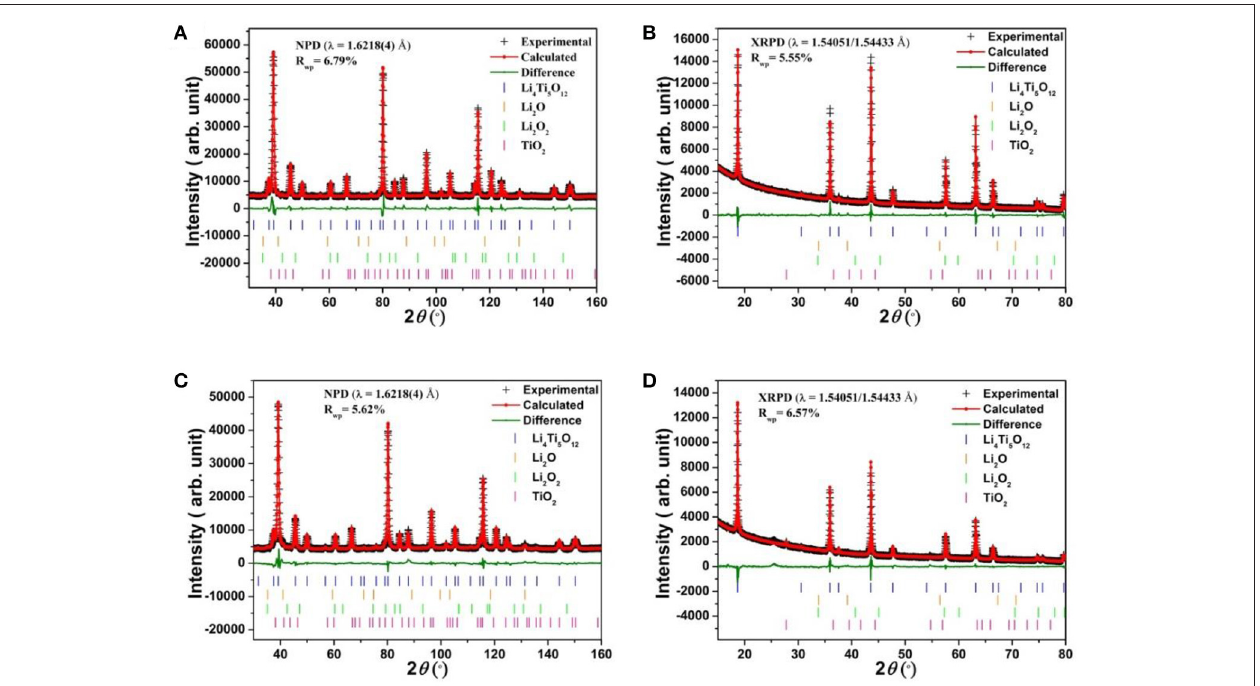
FIGURE 2 | Rietveld refinement profiles for (A) NPD and (B) XRPD data of LTO, and (C) NPD and (D) XRPD data of AlF 3 -coated LTO. The combined goodness-of-fit (GOF) are 2.58 and 2.15, respectively, and R wp is the weighted profile R-factor.